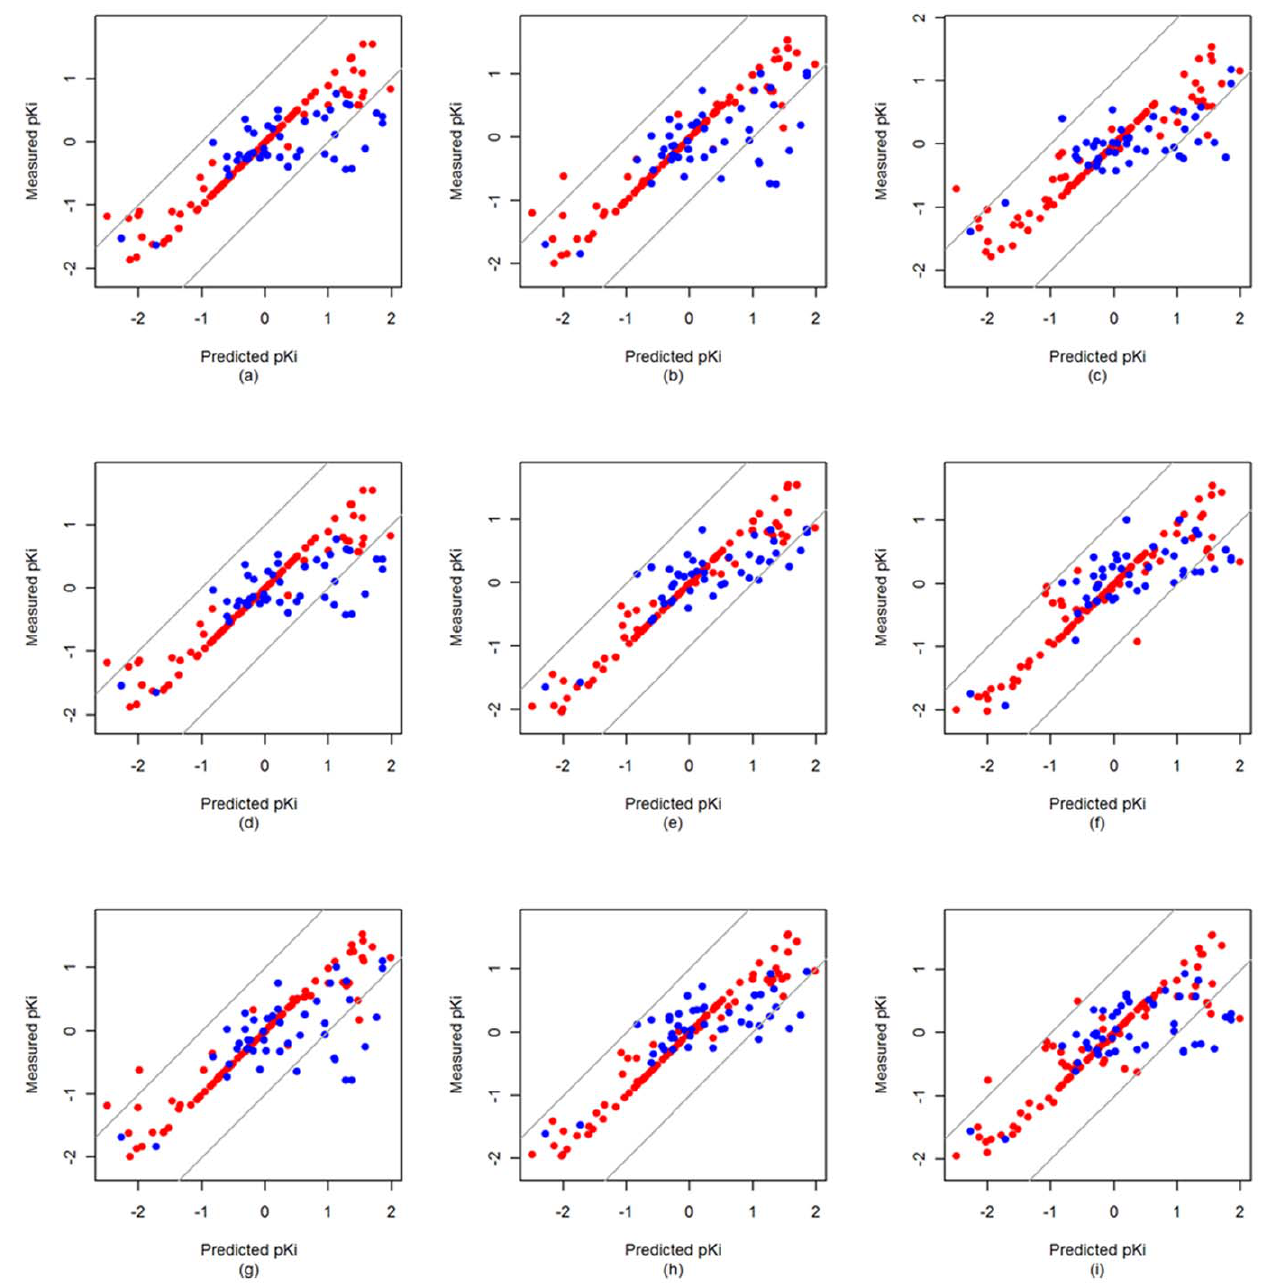
Figure 2. Predicted inhibitory activity (pKi) of the selected eight compounds against 47 proteases. Red, pink, brown, orange circles stand for the first-generation inhibitors, i.e. Saquinavir, Ritonavir, Indinavir, Nelfinavir respectively; Darkgreen, cadetblue, cyan, blue triangles stand for the second-generation ones, i.e. Darunavir, Tipranavir, TMC-126, XV638 respectively. The lines indicate the average values for each of them.